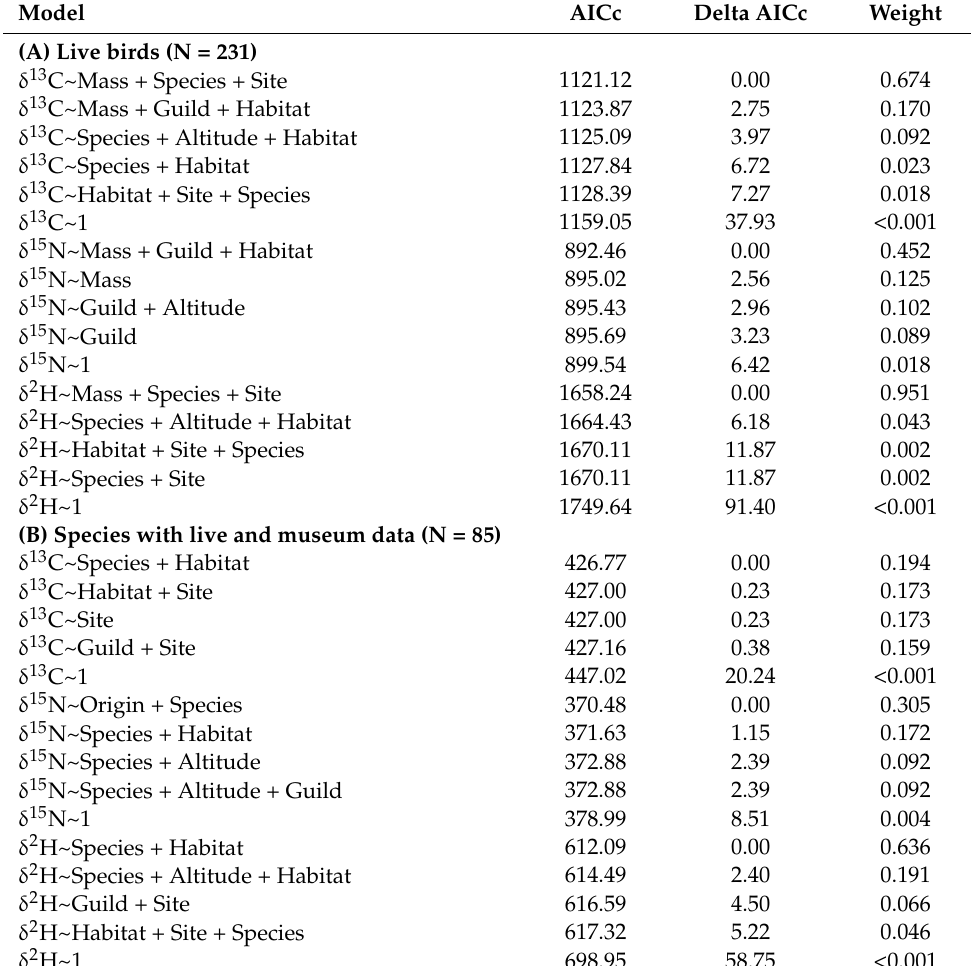
Table 2. Summary of results from the best generalized linear models (GLM) explaining the response variables (i.e., δ 13 C, δ 15 N and δ 2 H values) in each dataset analyzed: (A) Live birds (N = 231), and (B) Species with live and museum data (N = 85). Model AICc Delta AICc